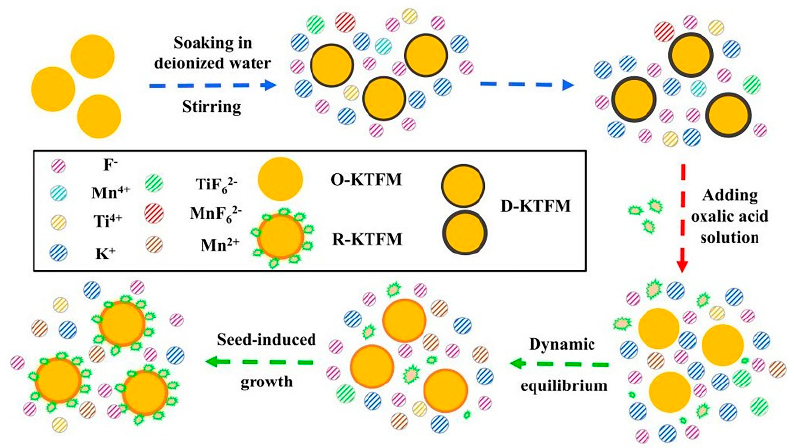
Figure 15. Schematic illustration of the reverse strategy of K 2 SiF 6 : Mn 4+ to restore luminescence and improve moisture-resistance. (Reprinted from Ref [55]. Copyright from John Wiley and Sons Ltd., 2020).